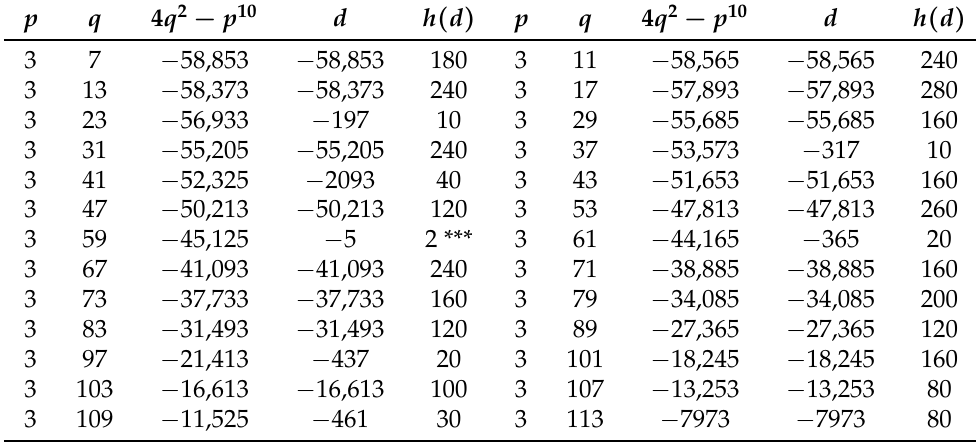
Table 8. Numerical examples for n =